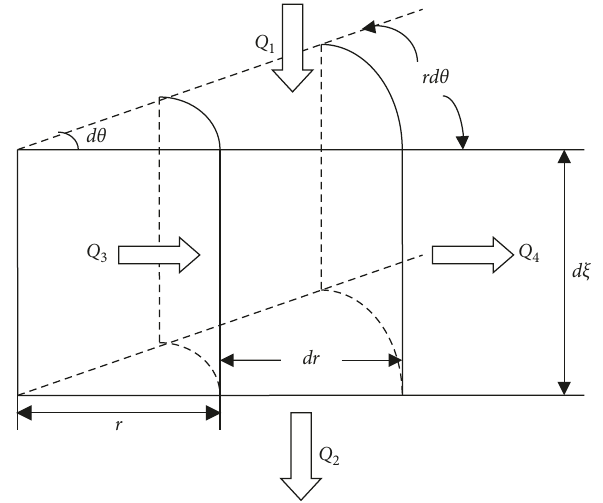
Figure 2: The diagram of coordinates